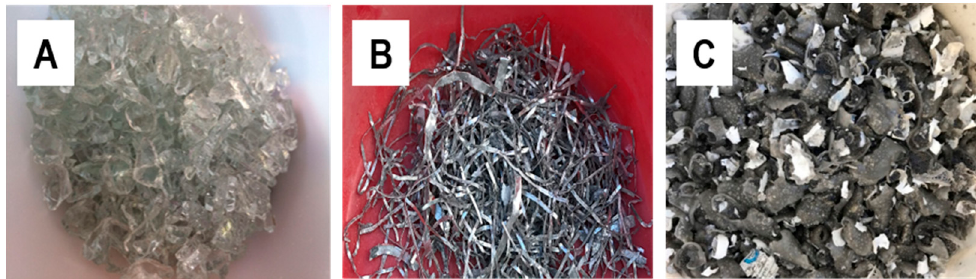
Figure 4. Recovered fractions from solvent treatment operations: solar grade glass ( A ), metallic Figure4. Recoveredfractionsfromsolventtreatmentoperations: solargradeglass( A ),metallicfilaments filaments ( B ), and polymeric residue ( C ). ( B ), and polymeric residue ( C ). Table 1. Mass balance and fraction composition for the PhotoLife process